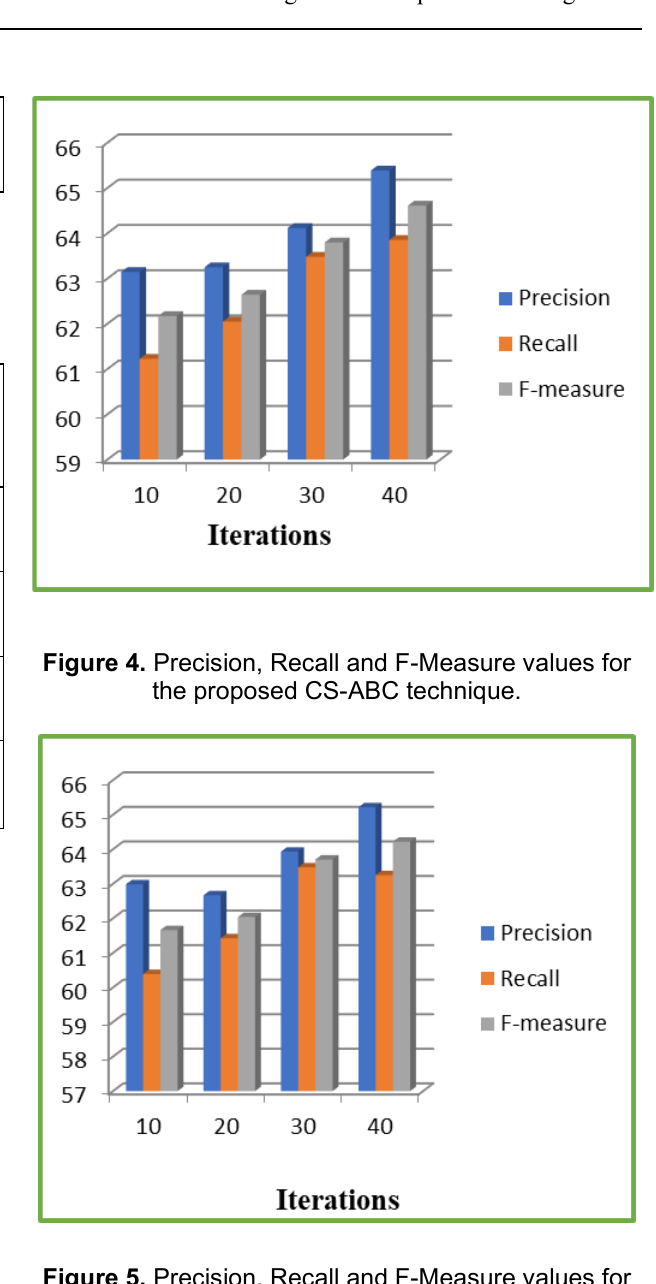
Figure 5. Precision, Recall and F-Measure values for the existing ABC